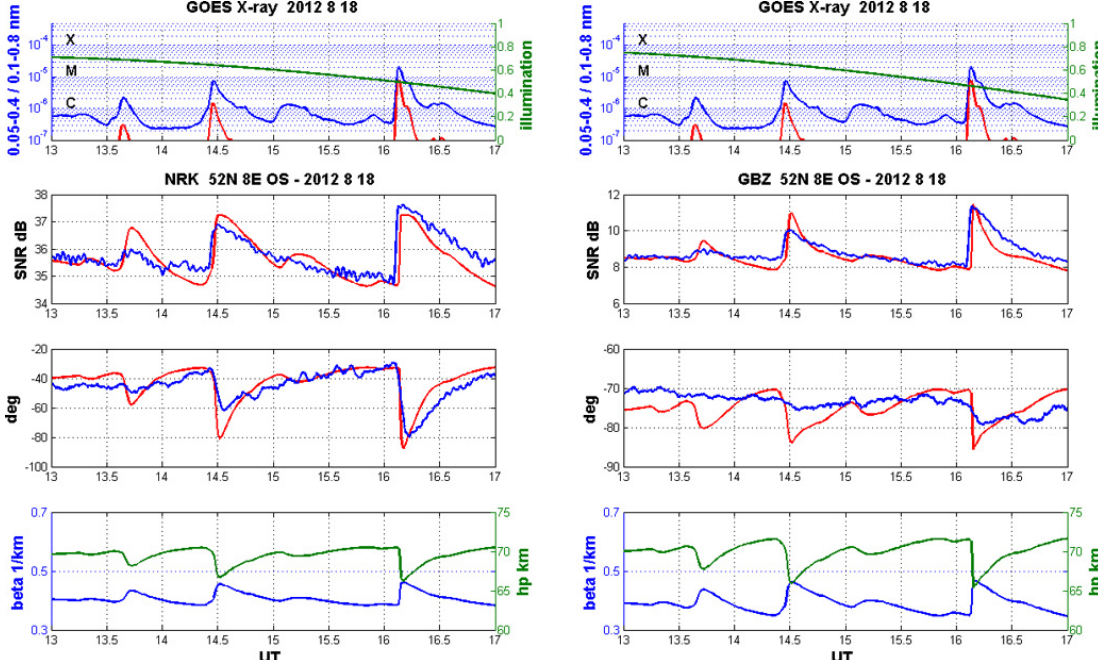
Fig. 8. On 18 August 2012, detail 13:00–17:00UT; for the parameters see Fig. 7. In the middle panels (amplitude and phase) blue and red are the recorded and calculated values,